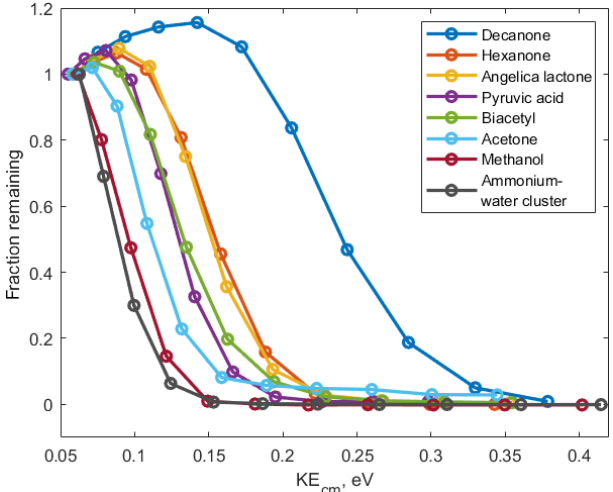
Figure 3. De-clustering scans of ammonium–organic clusters (cid:113) NH + (VOC) for calibrated components and NH + 4